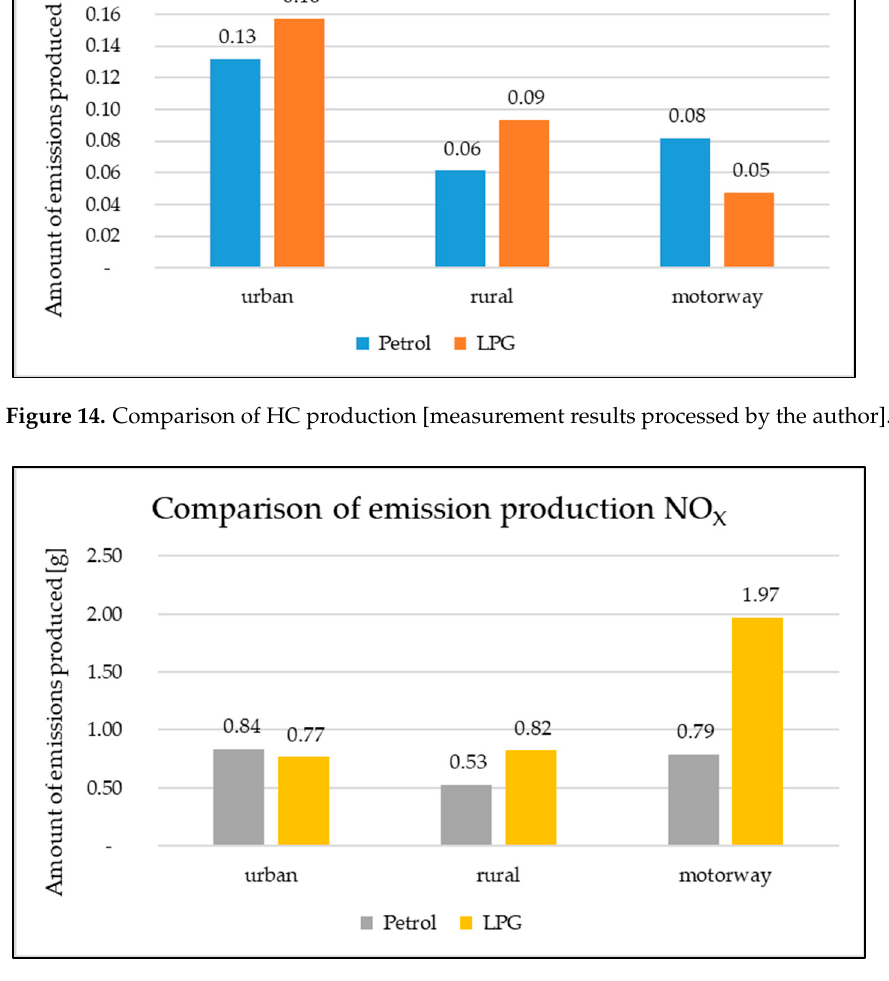
Figure 15. Comparison of NO X production [measurement results processed by the author].